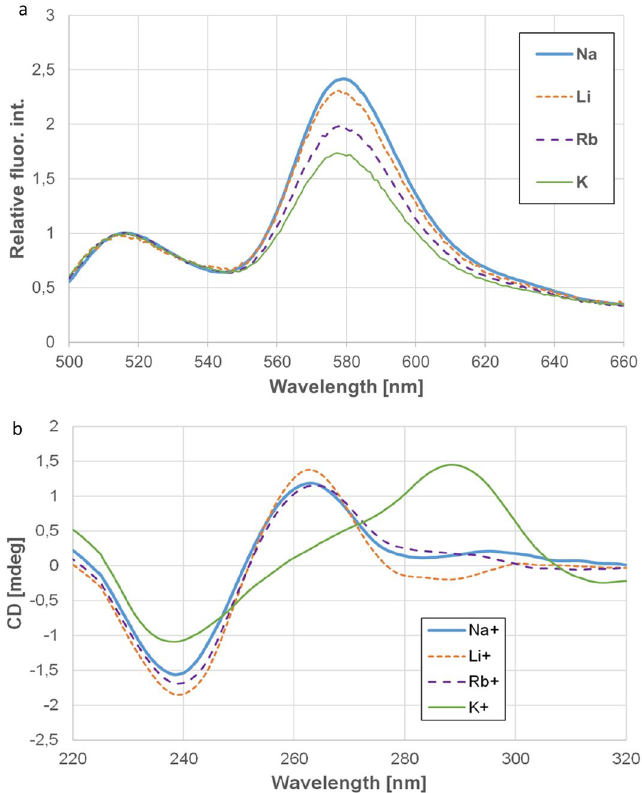
Figure 2. ( a ) Fluorescence spectra of HepB_FRET in presence of Na + , K + , Li + and Rb + at 30 °C. These spectra are normalized to the donor intensity around 518 nm. ( b ) CD spectra of HepB at room temperature in presence of the same